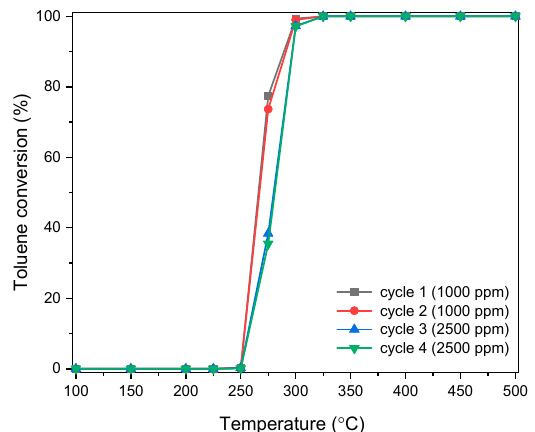
Figure 10. Catalytic activity in toluene combustion over PS30_Si_Co15_B in four successive reaction cycles (toluene concentration: cycles 1 and 2—1000 ppm, cycles 3 and 4—2500 ppm).